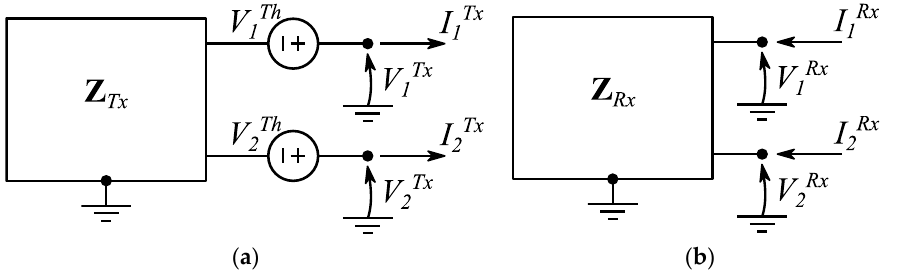
Figure 3. Behavioral model representation of PLC modems: ( a ) Thevenin equivalent circuit for the PLC Tx, and ( b ) impedance representation for the PLC Rx.